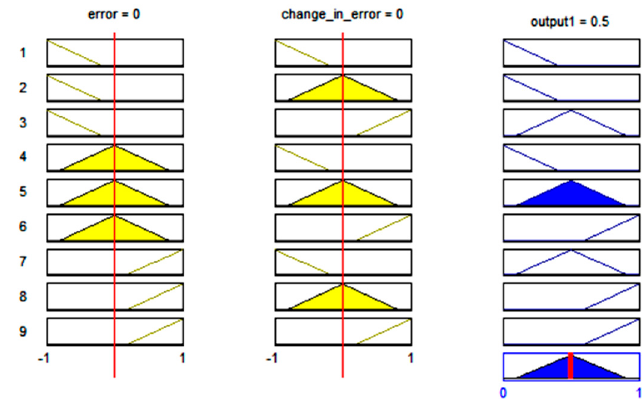
Figure 15. Rule viewer plot for Rule 1.